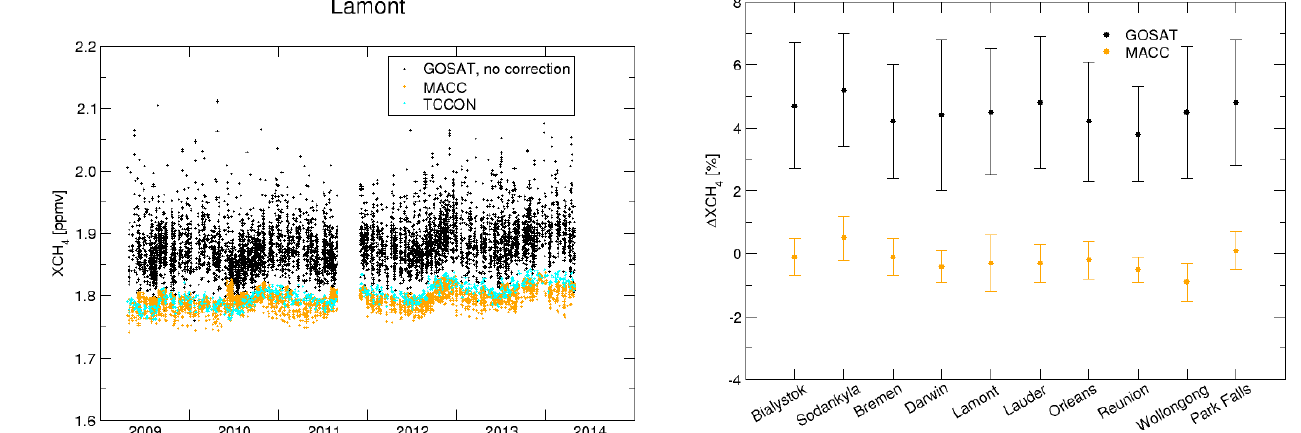
Figure 3. Total methane columns as a time series over Lamont. In black the GOSAT-TIR retrievals are shown. In orange and cyan, the corresponding (non-scaled) MACC and TCCON total columns are shown, respectively.